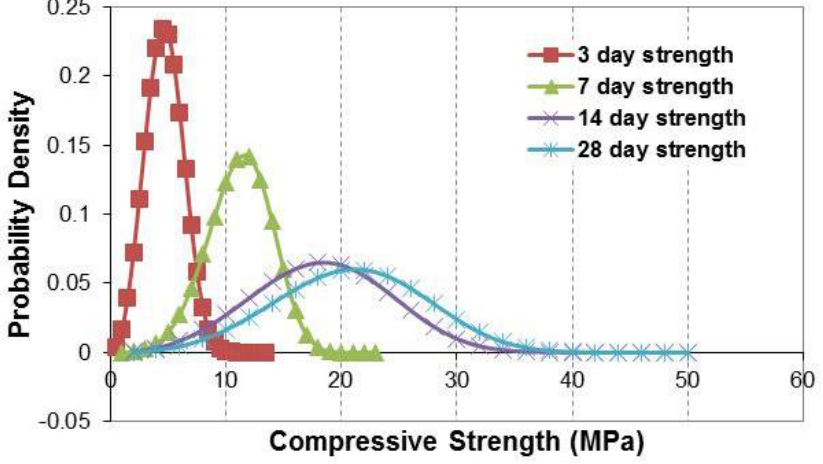
Figure 5. Weibull distribution of concrete compressive strength.